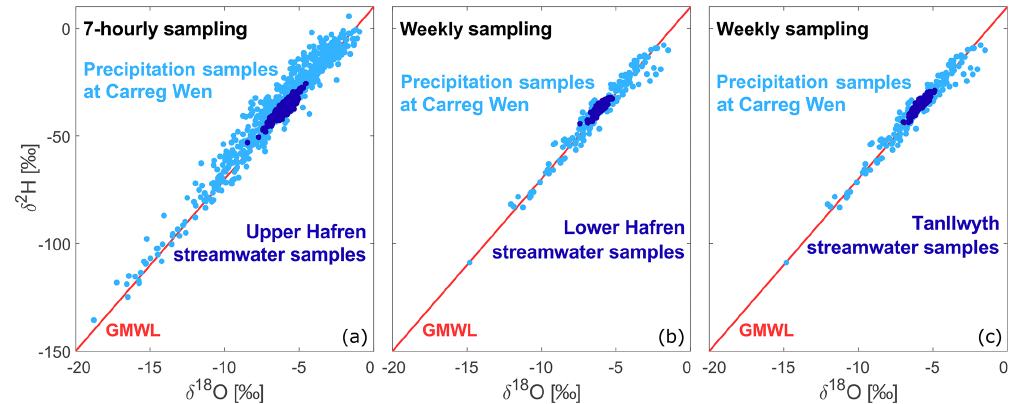
Figure 2. Dual-isotope plots for precipitation (light blue) and streamwater (dark blue) samples from 7-hourly (a) and weekly sampling (b– c) . Both precipitation and streamwater samples generally fall close to the global meteoric water line (GMWL, red line) and thus show little evidence of evaporative